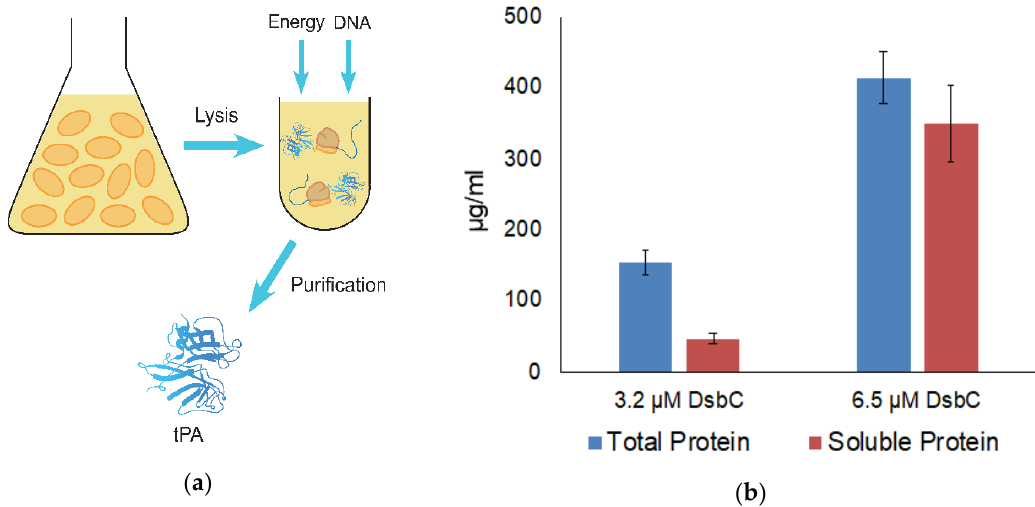
Figure 1. ( a ) Schematic showing the tissue plasminogen activator (tPA) expression process using a cell-free protein synthesis (CFPS) platform. E. coli cells are first grown and lysed. Next, cell extract, energy and DNA are all combined to express tPA which is then purified; ( b ) Total and soluble tPA yield with disulfide bond isomerase C (DsbC). Both reactions were incubated at 37 °C for 3 h. The final concentration of DsbC in each reaction is shown. Error bars represent one standard deviation.